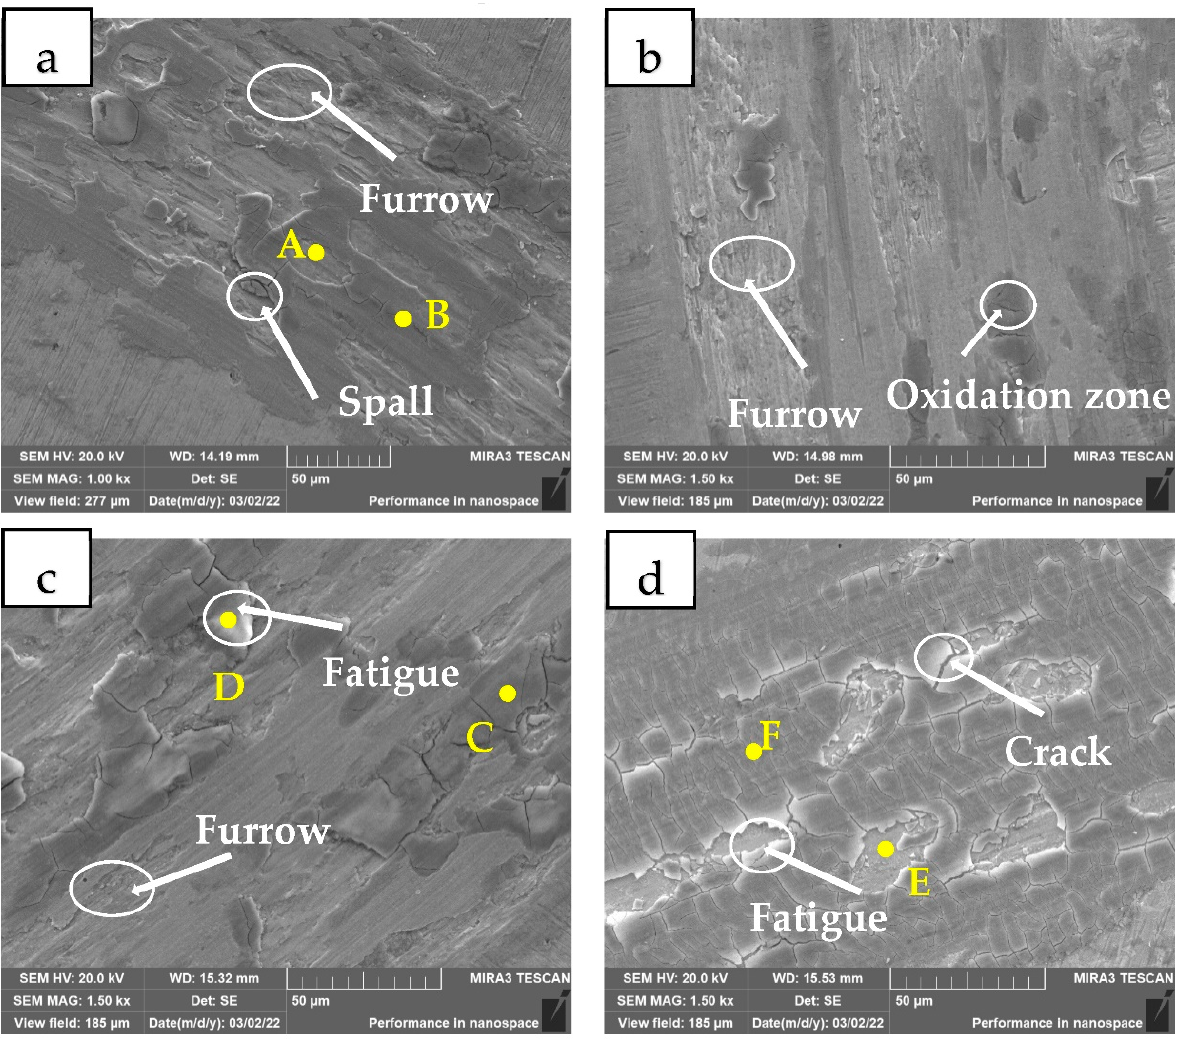
Figure 7. SEM images of different coatings after wear ( a ) 0 WC; ( b ) 5 WC; ( c ) 15 WC; ( d ) 20 WC. A—The spalling pit, B, C—The oxidized area, D—The fatigue wear area, E—Oxidation layer peeling pit, F—Crack. Table 6. EDS of the friction zone of the coatings (wt.%).